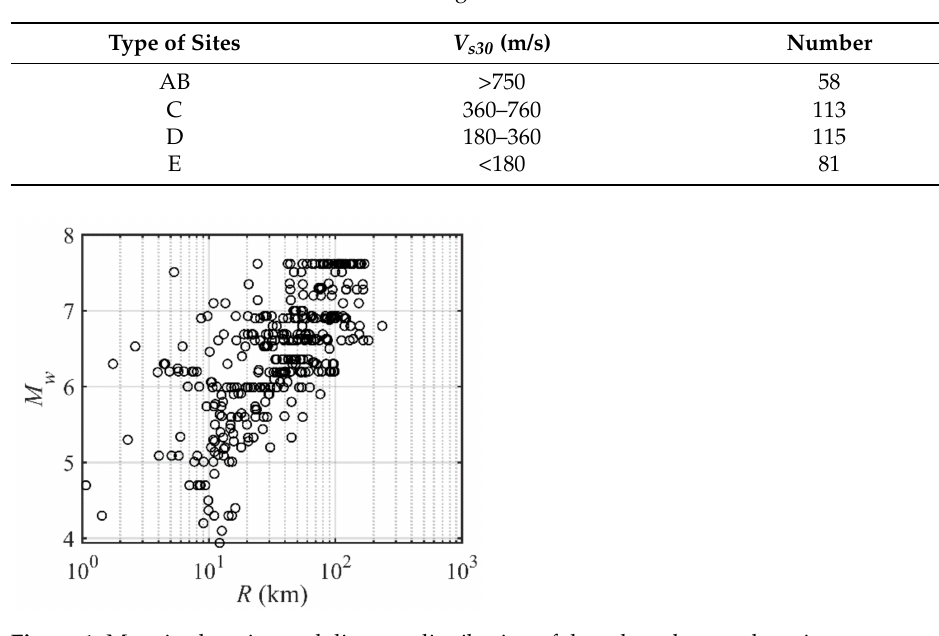
Figure 1. Magnitude-epicentral distance distribution of the selected ground motions.